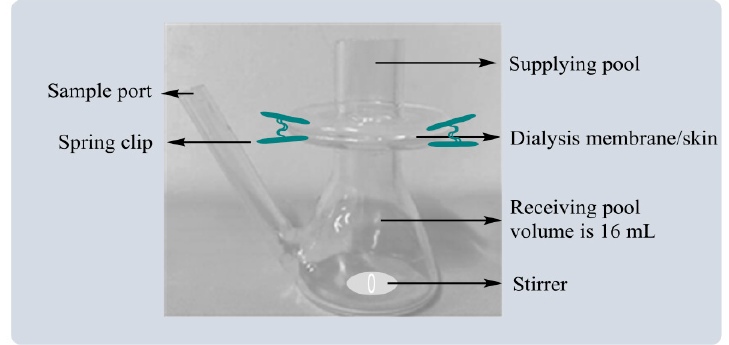
Figure 1. The diagram of Franz diffusion